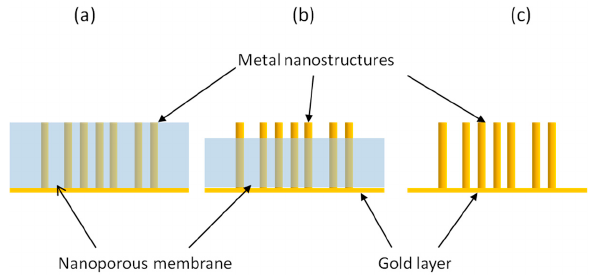
Figure 11. Different geometries for template nanoelectrode ensembles: ( a ) ensemble of nanodisks; ( b ) ensemble of partially naked nanowires; ( c ) ensemble of completely naked.